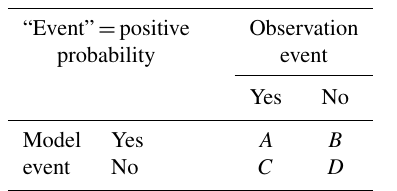
Table 3. Contingency table where “ A ” is the number of event fore- casts that correspond to event observations or the number of hits. Entry “ B ” is the number of event forecasts that do not correspond to observed events or the number of false alarms. Entry “ C ” is the number of no-event forecasts corresponding to observed events or the number of misses. Entry “ D ” is the number of no-event fore- casts corresponding to no events observed or the number of correct